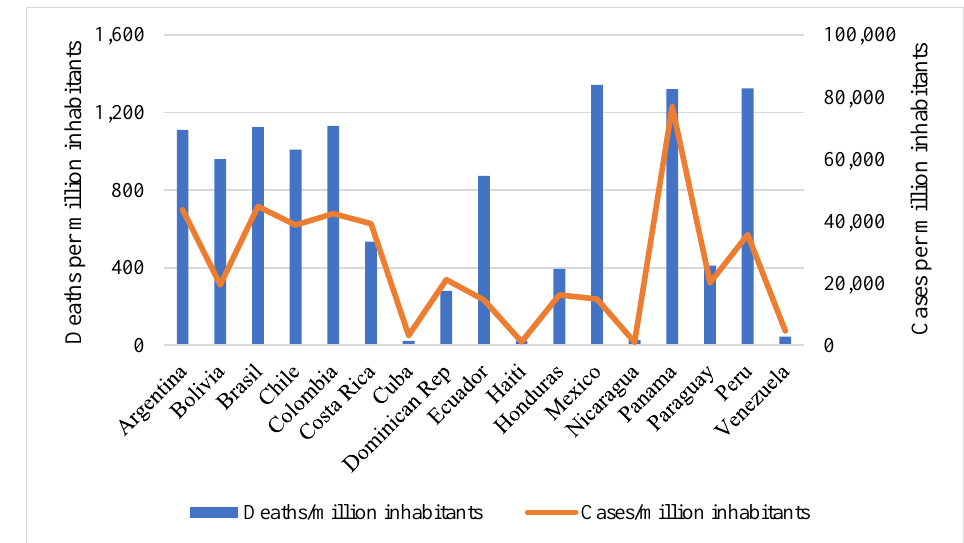
Figure 1. Number of COVID-19 deaths and cumulative confirmed cases of infection counted per million inhabitants. Source: own elaboration based on data provided by the World Bank. Data updated through February 2021.